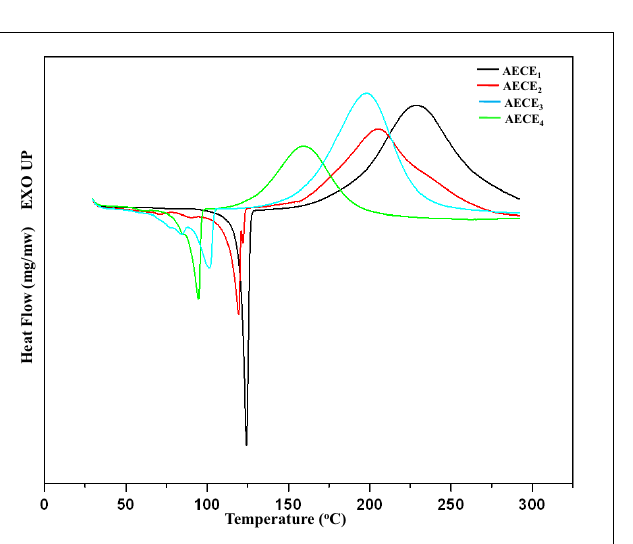
Figure 2 | Curing behaviors of cyanate ester monomers (AECE 1 - 4 ).